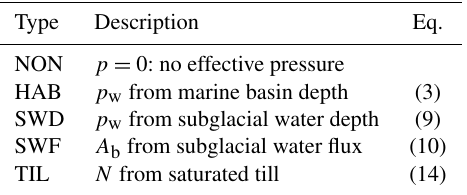
Table 2. Summary of the subglacial models.